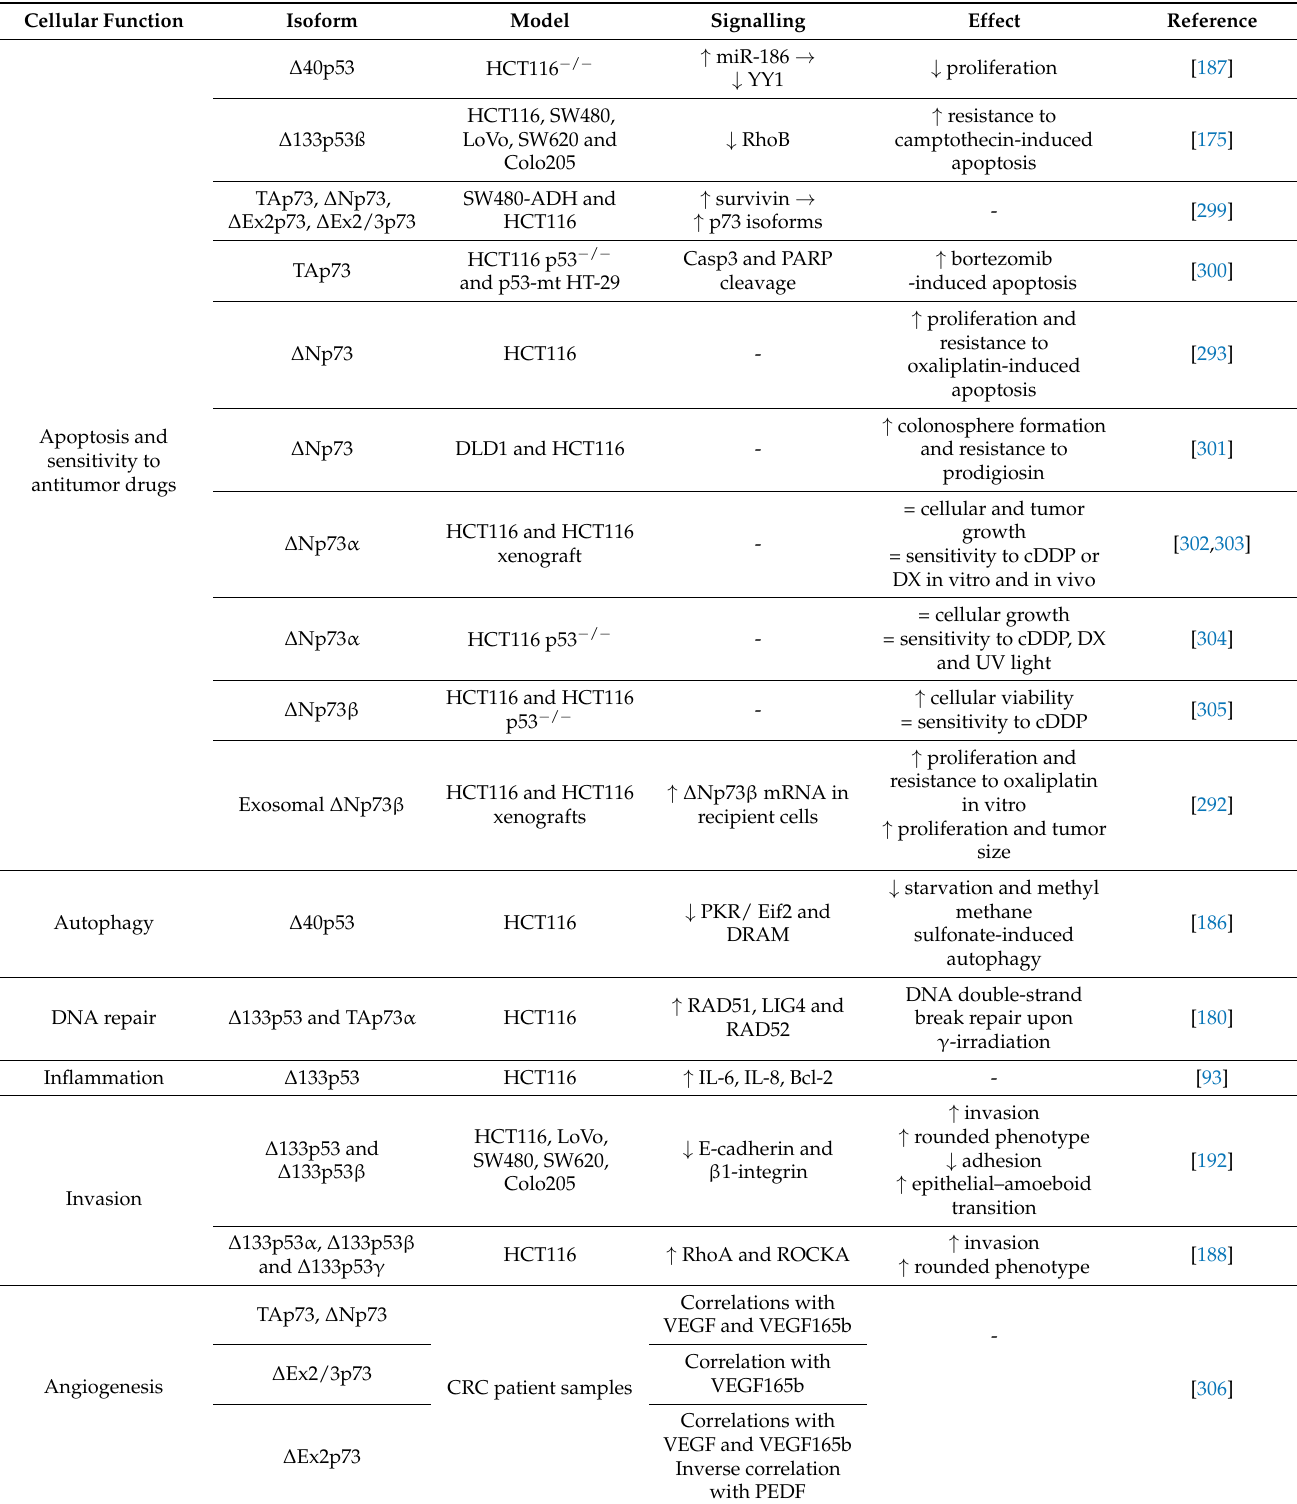
Table 1. Involvement of the p53/p73 isoforms in colorectal cancer development and progression. The p53/p73 family of isoforms is associated with a plethora of cancer-related cellular functions such as apoptosis and sensitivity to drugs, DNA repair, autophagy, proliferation, inflammation, invasion, angiogenesis, metabolism, and